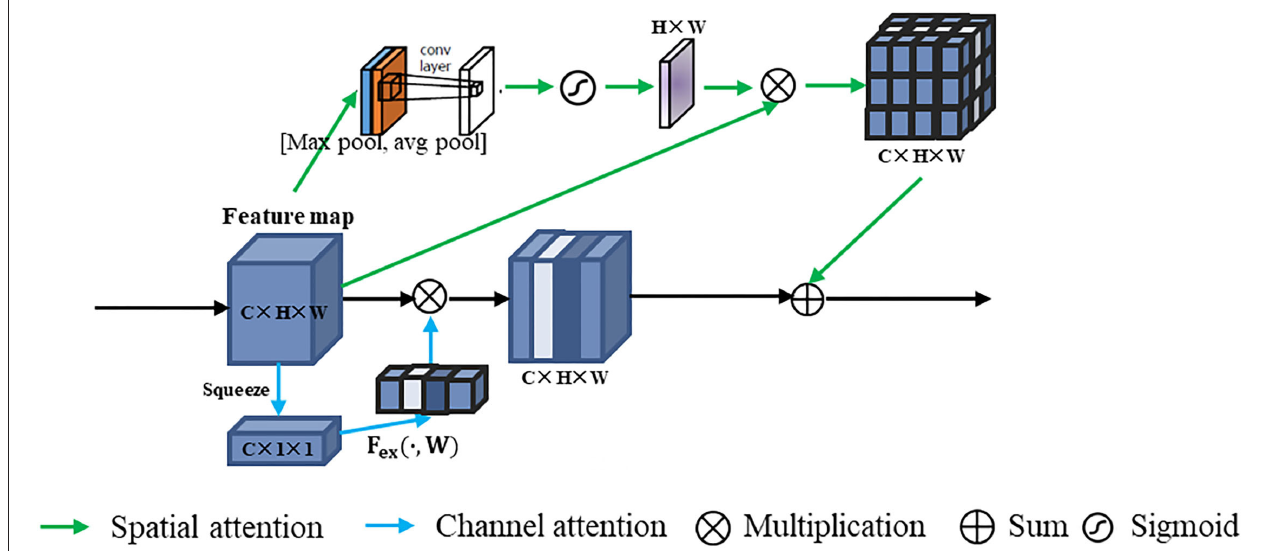
FIGURE 4 | Intra-phase attention structure. All three phase branches are operated in the same way, but we have shown only one phase example here.